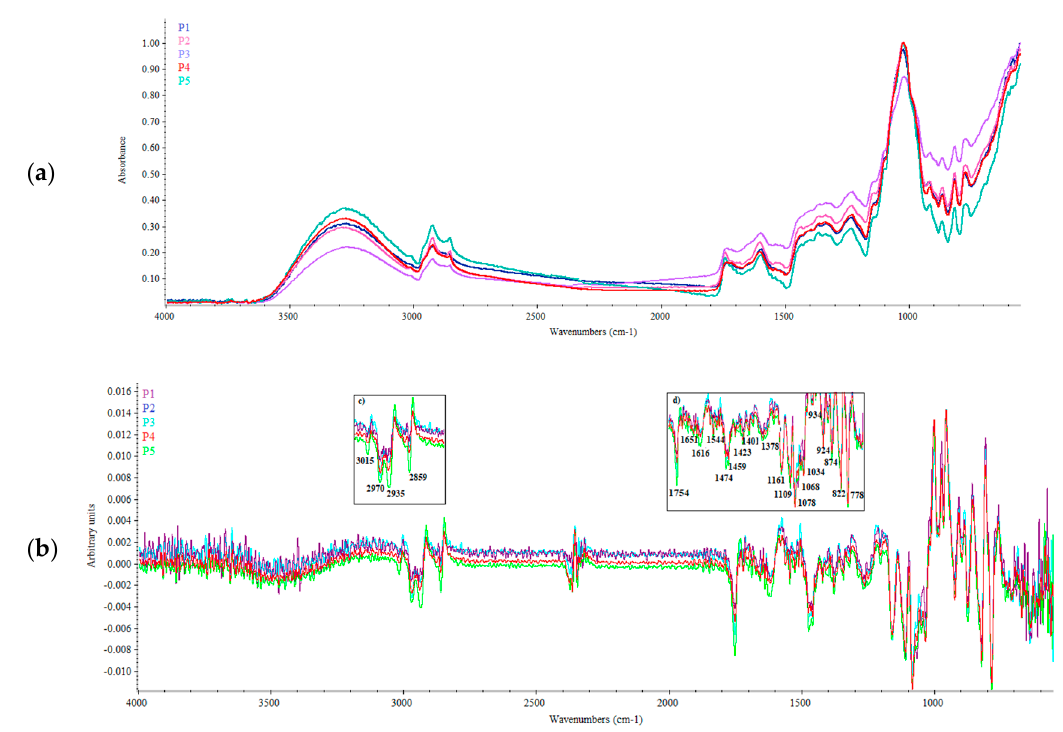
Figure1. AverageIRspectraof A.unedo wildberriesanalyzed: ( a )rawspectra; ( b Figure 1. Average IR spectra of A. unedo wild berries analyzed: ( a ) raw spectra; ( b ) first derivative spectra.